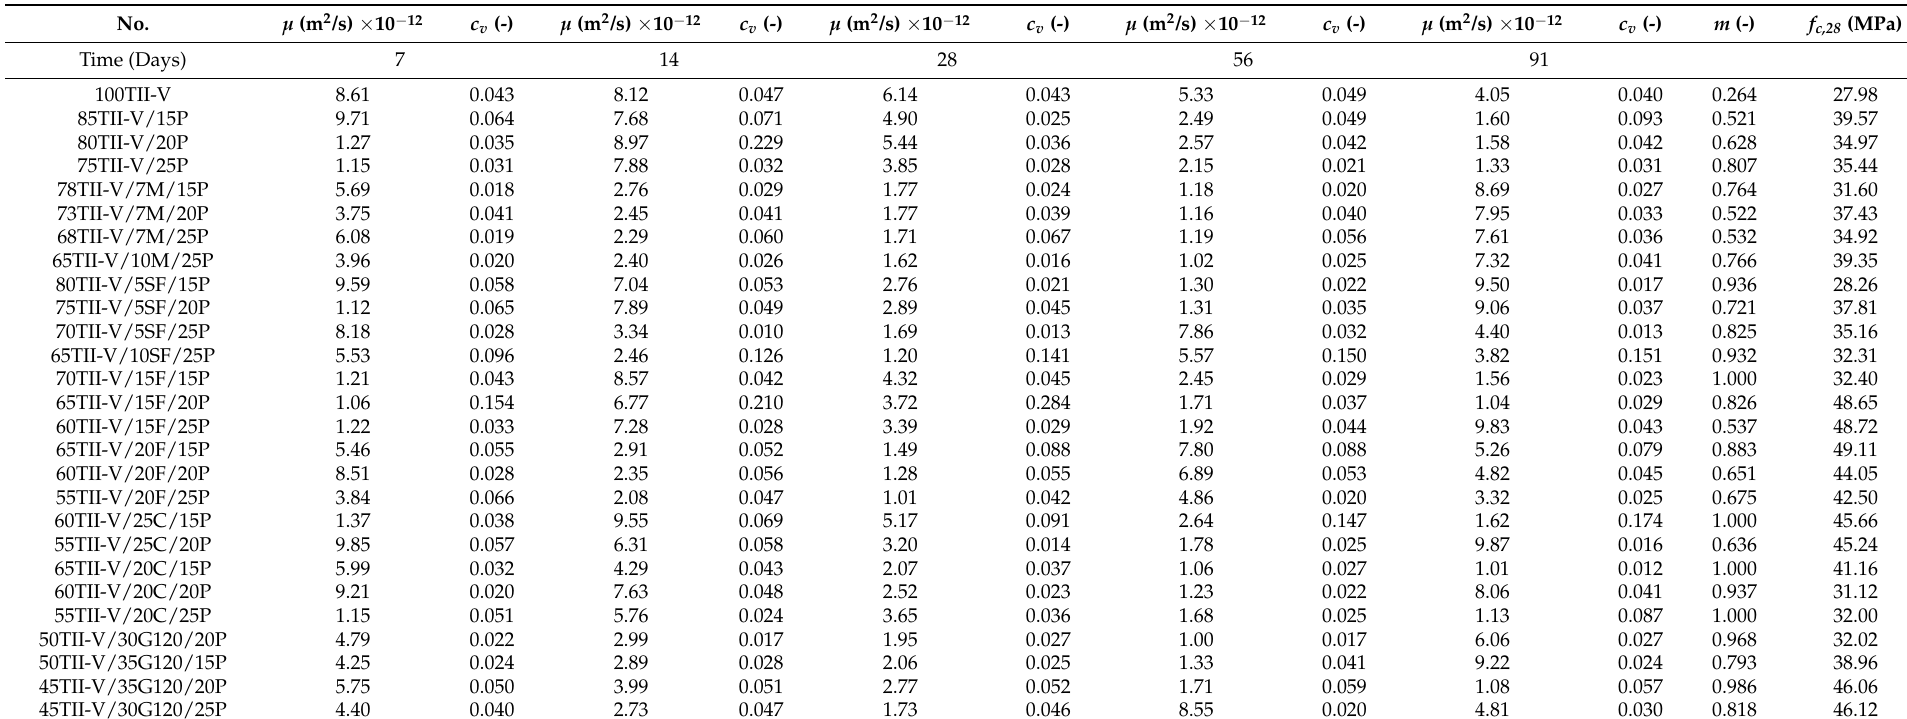
Table 2. Mean value of diffusion coefficient µ (m 2 /s) and variation coefficient c v (-) in time t (days), and calculated aging factor m (-) and compressive strength f c,28 (MPa).